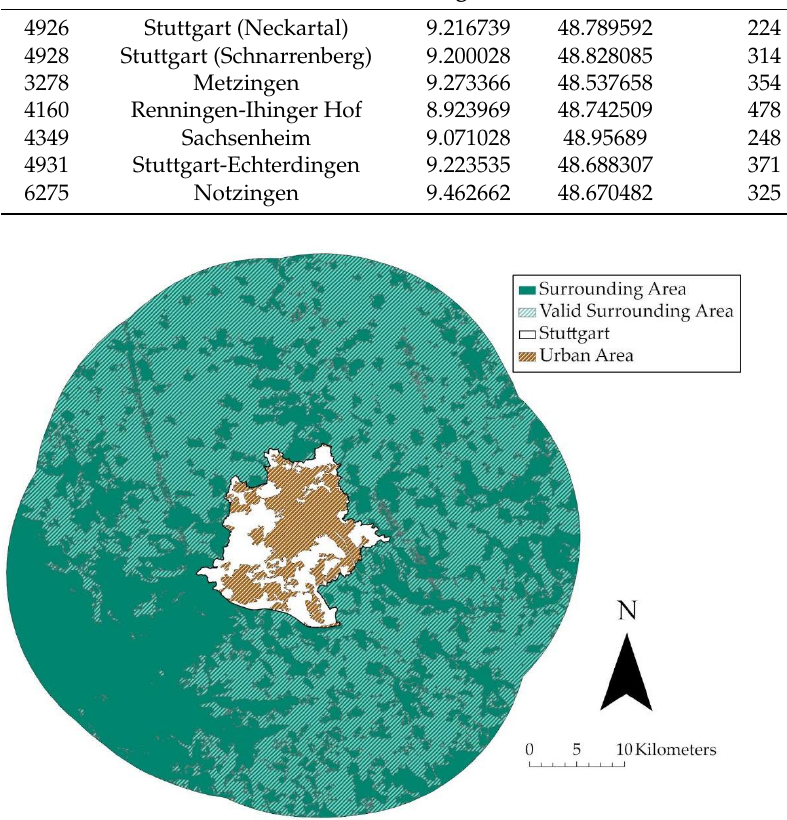
Figure A1. Stuttgart and its surrounding area. Green hatching indicates the valid surrounding area in the 20 km buffer around Stuttgart used to calculate the average rural land surface temperature (LST). Urban areas, areas covered with clouds, and areas with elevation deviating more than ±100 m from the mean elevation of Stuttgart were excluded.